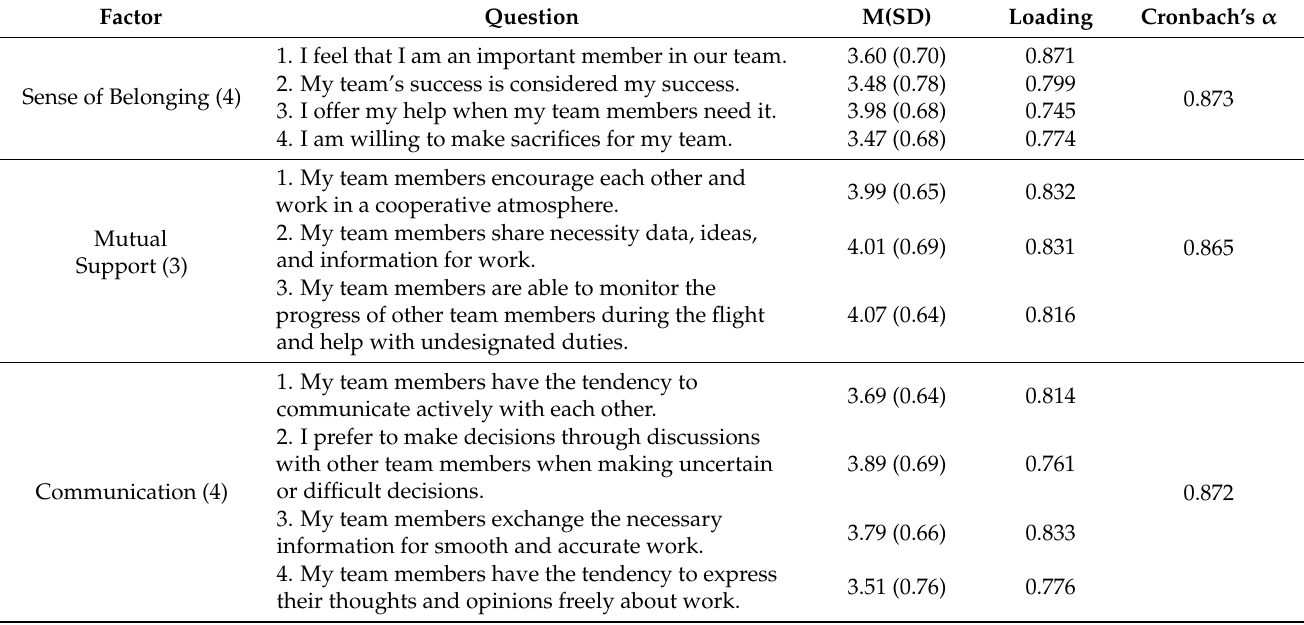
Figure 5. Structural equation model analysis results.